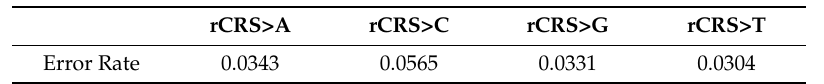
Table 3. Substitution-based error rates for A, C, G, and T base calls. Error Rates represent the total numbers of calls made in error at all nucleotide positions (16,569 positions) divided by the total number of sequencing base